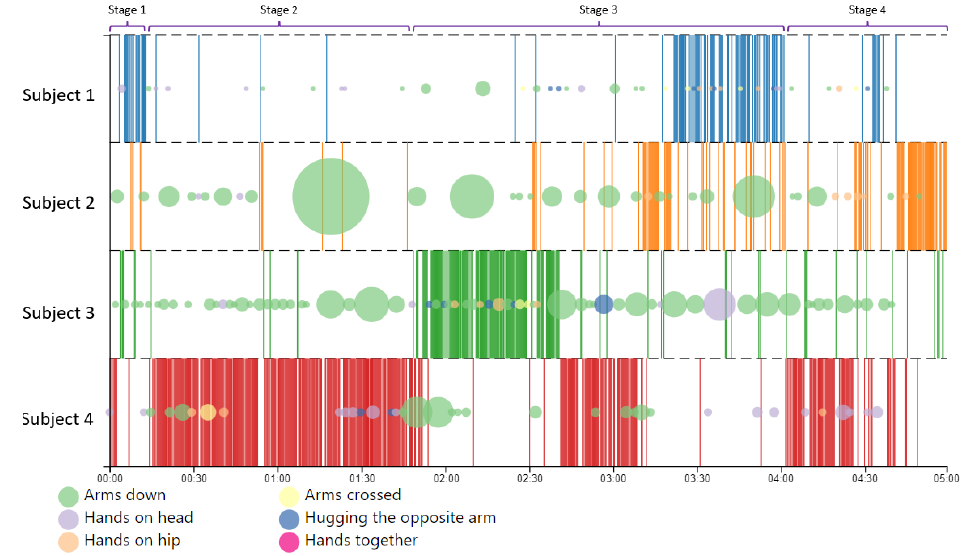
Figure 4. Timeline visualization for the Collaborative